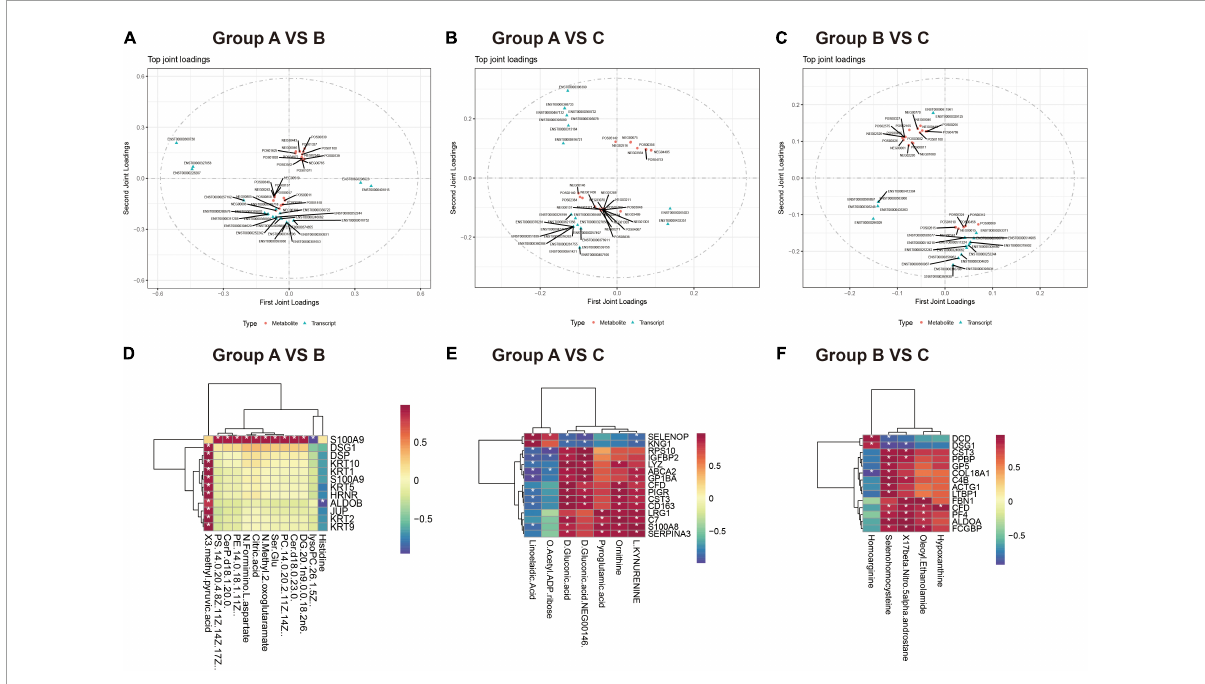
FIGURE6 Integrative metabolomics-proteomics analysis in healthy control, HZ, and PHZ groups. (A–C) Loadings plots of differentially expressed metabolites and proteins altered in differential compared groups. (A) Group A vs. B, (B) group A vs. C, (C) group B vs. C. The loading value represents the explanatory ability of the variable (metabolite/protein) in each component, and the positive and negative values represent a positive or negative correlation with other omics. The greater the absolute value of the load value, the stronger the correlation. (D–E) Correlation heatmap between differential metabolites and proteins among groups. (D) Group A vs. B, (E) group A vs. C, (F) group B vs. C. Red represents increased expression, and blue represents decreased